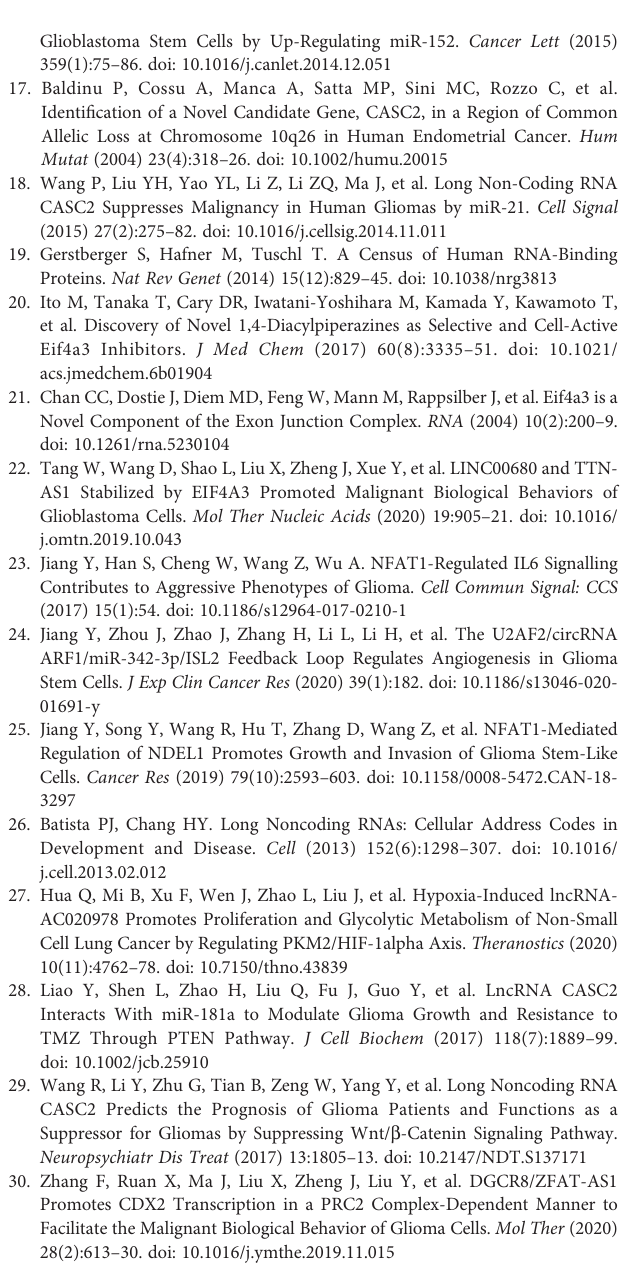
Supplementary Figure 8 | The expression of TGF- b 1 after CASC2 or EIF4A3 knockdown or overexpression. (A, B) qPCR (A) and western blotting (B) showing the expression of TGF- b 1 increased in U87 cells and GSC2C after CASC2 knockdown. (C, D) qPCR (C) and western blotting (D) showing the expression of TGF- b 1 decreased in T98G cells and GSC4D after CASC2 overexpression. (E, F) qPCR (E) and western blotting (F) showing the expression of TGF- b 1 decreased in U87 cells and GSC2C after EIF4A3 knockdown. (G, H) qPCR (G) and western blotting (H) showing the expression of TGF- b 1 increased in T98G cells and GSC4D after EIF4A3 overexpression. EV, empty vector; OE, overexpression; NC, negative control; KD, knockdown. All data are expressed as the mean ± SD (three independent experiments). *P < 0.05; **P < 0.01; ***P <